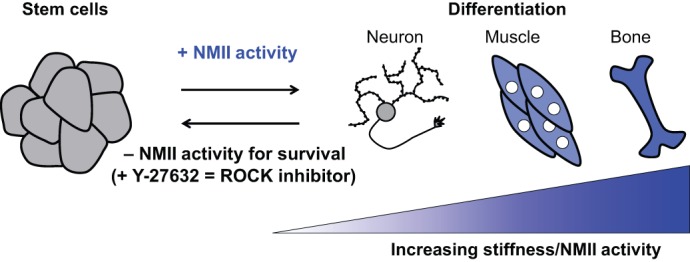
NMII determines stem cell fate. Pluripotent stem cells are cultured in the presence of the ROCK inhibitor Y-27632 to prevent apoptosis (Chen et al., 2010; Watanabe et al., 2007). NMII activity directs the differentiation of stem cells to specific tissue lineages: decreased NMII activity leads to neuronal fates, whereas increased NMII activity promotes the formation of stiffer tissues, such as muscle and bone (Engler et al., 2006; Seo et al., 2014; Wang et al., 2013b).